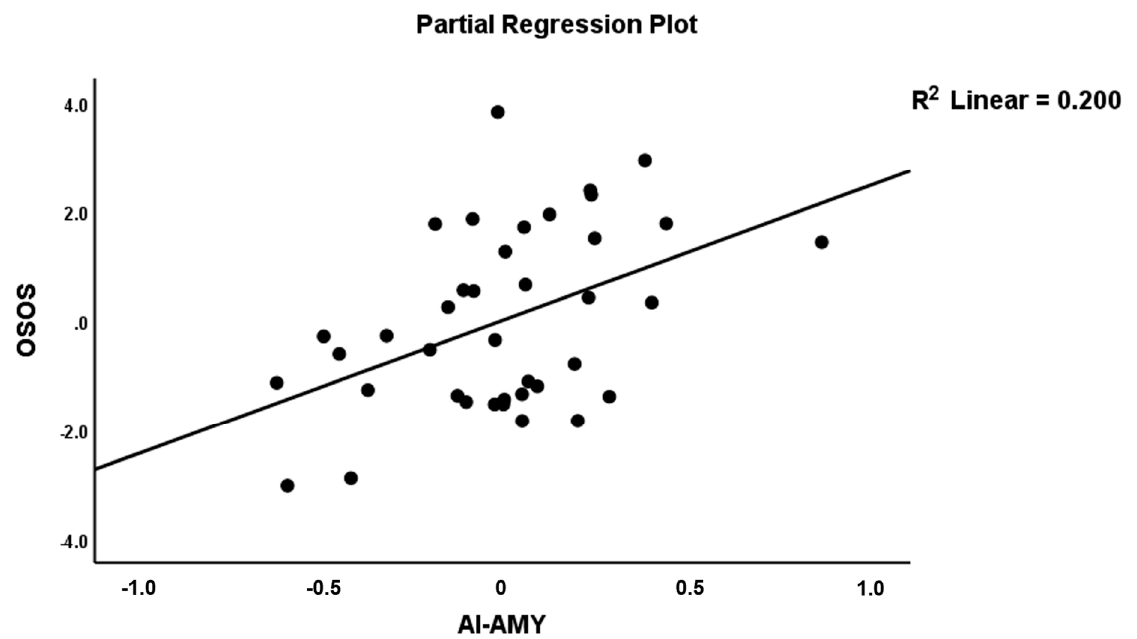
Figure 5. Partial regression plot of the OSOS score on the AI → AMY connection.